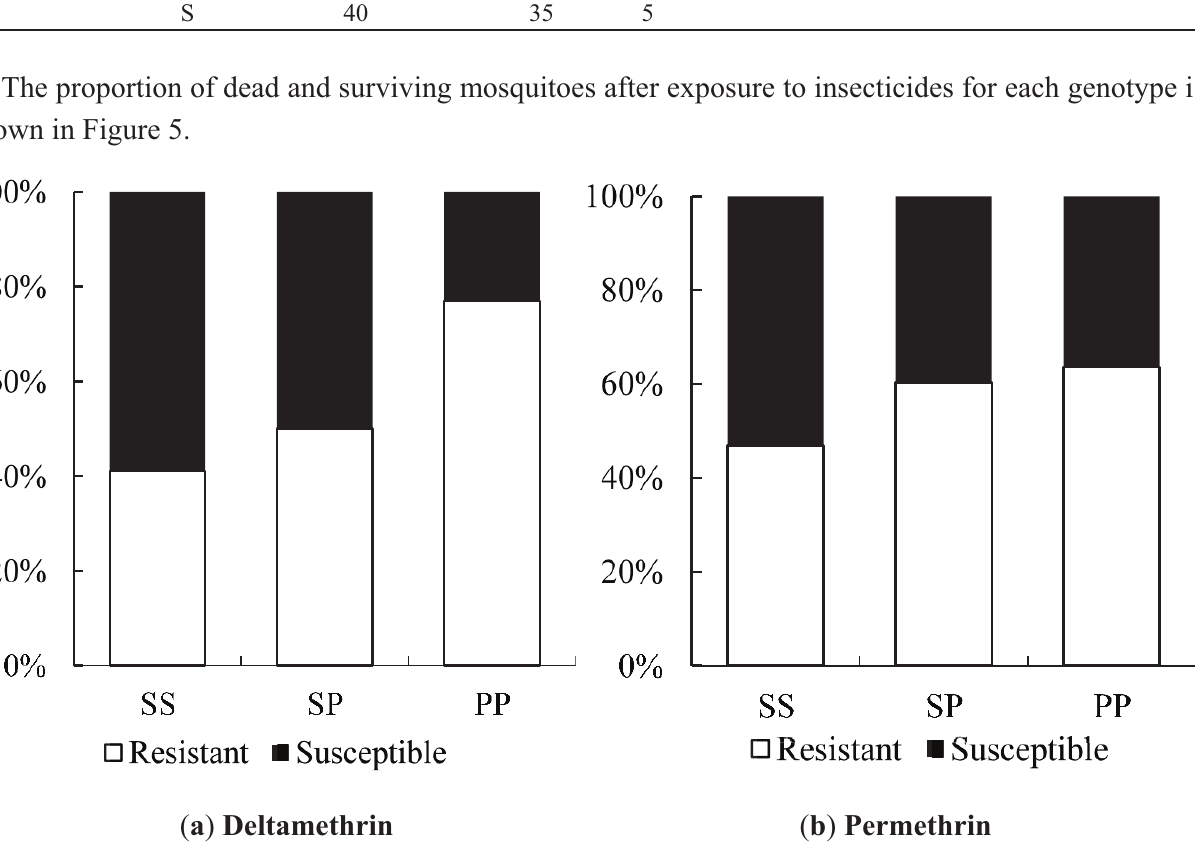
Figure 5. Association between Vssc S996P mutations and resistance to pyrethroids in Ae . aegypti from Yogyakarta (Site 6, Site 8 and w MelYog line). ( a ) Distribution of S996P genotypes between deltamethrin-resistant and deltamethrin-susceptible mosquitoes; ( b ) Distribution of S996P genotypes between permethrin-resistant and permethrin-susceptible